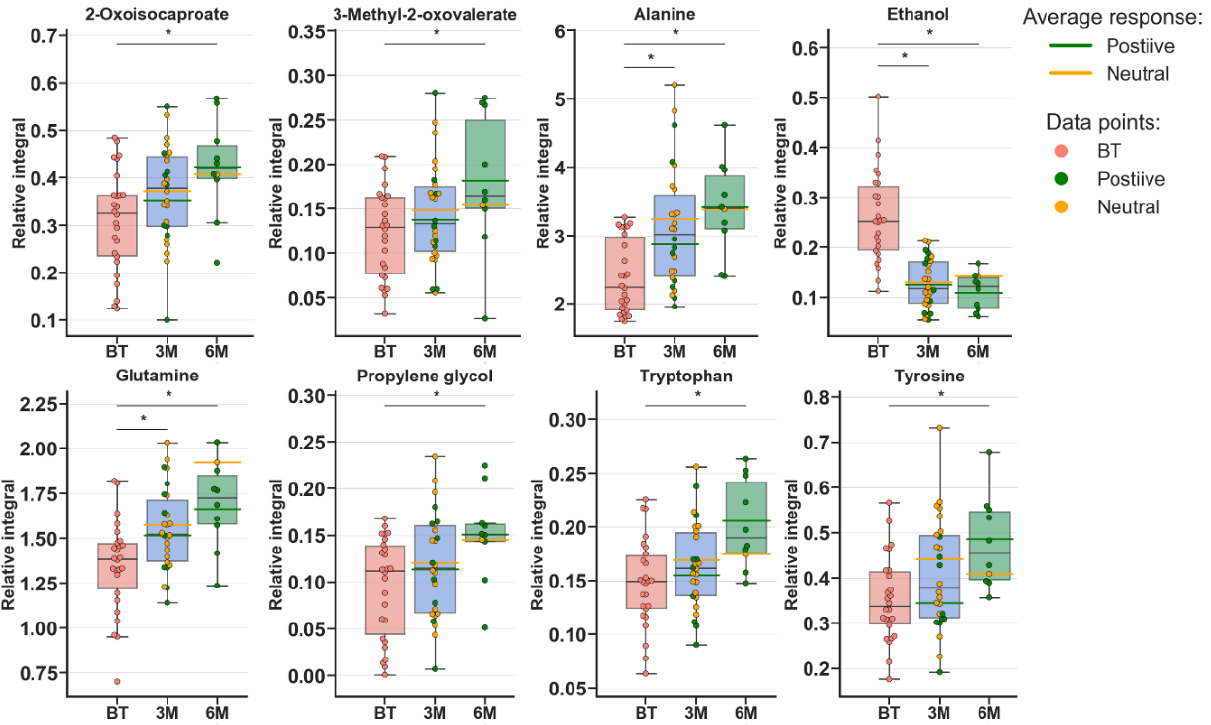
Int. J. Mol. Sci. 2021 , 22 , 7389 Figure 1. PCA model plot and corresponding loading plot for RA patients studied at three time points. Red — RA patients before treatment; blue — 3 months after initialization of anti-TNF treatment; green — 6 months after treatment with TNFi.